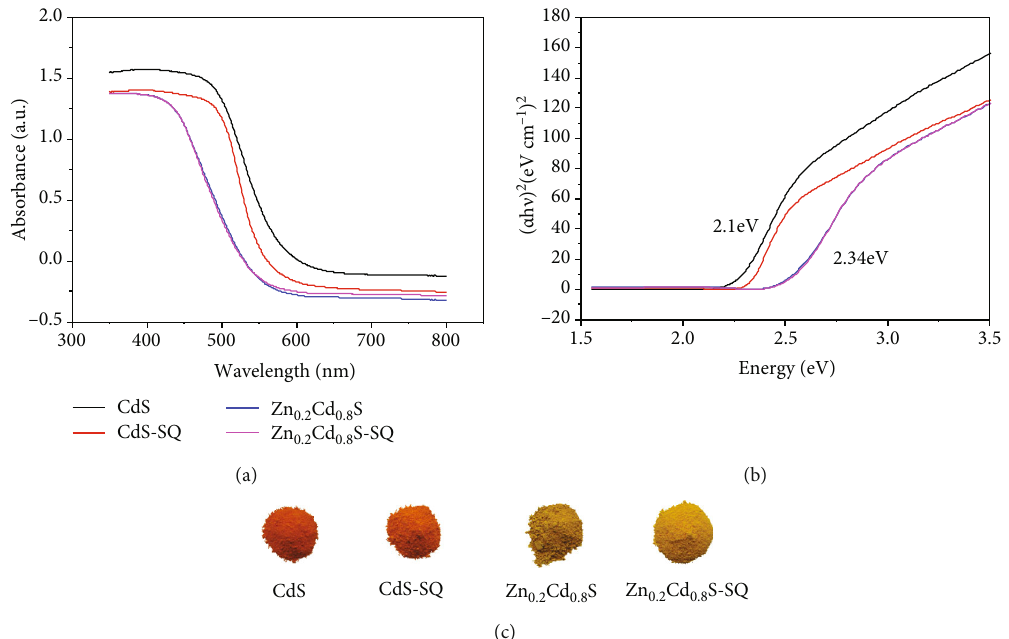
Figure 8: Di ff use re fl ectance (DR) UV-Vis spectra of pure CdS, CdS-SQ, Zn (b), and sample colorings